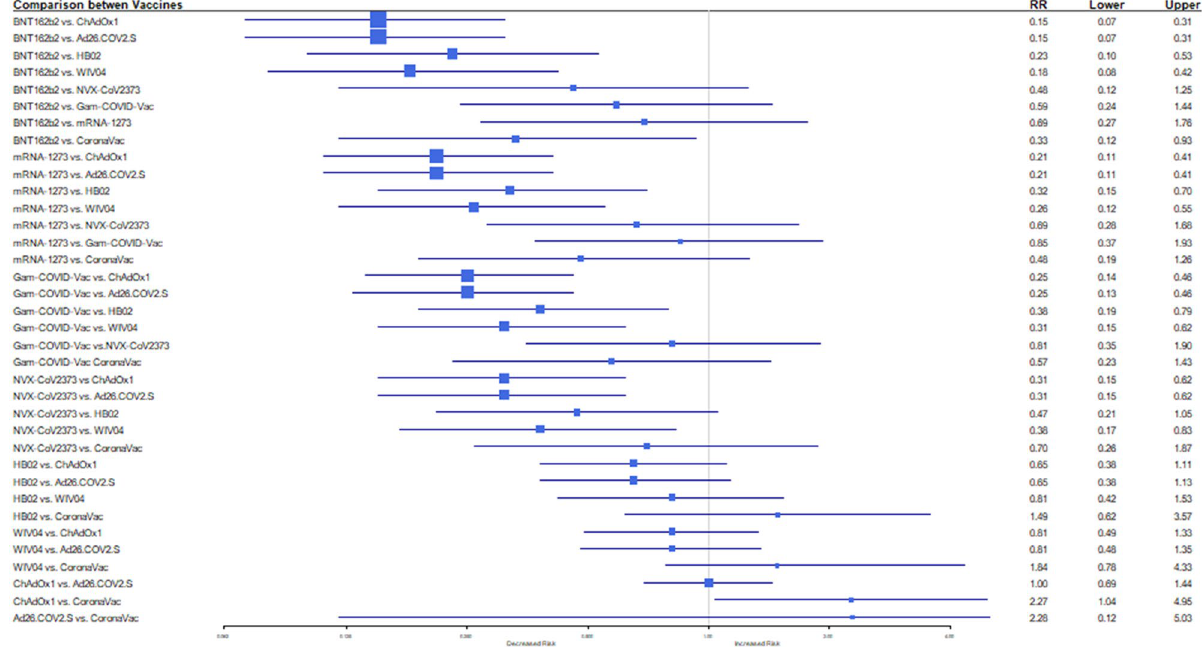
Figure 1. Results of random-effects network meta-analysis for efficacy to prevent symptomatic COVID-19: Risk Ratio (RR) for indirect comparison between the vaccines or vaccine vs. placebo, and 95% confidence intervals (Seven studies